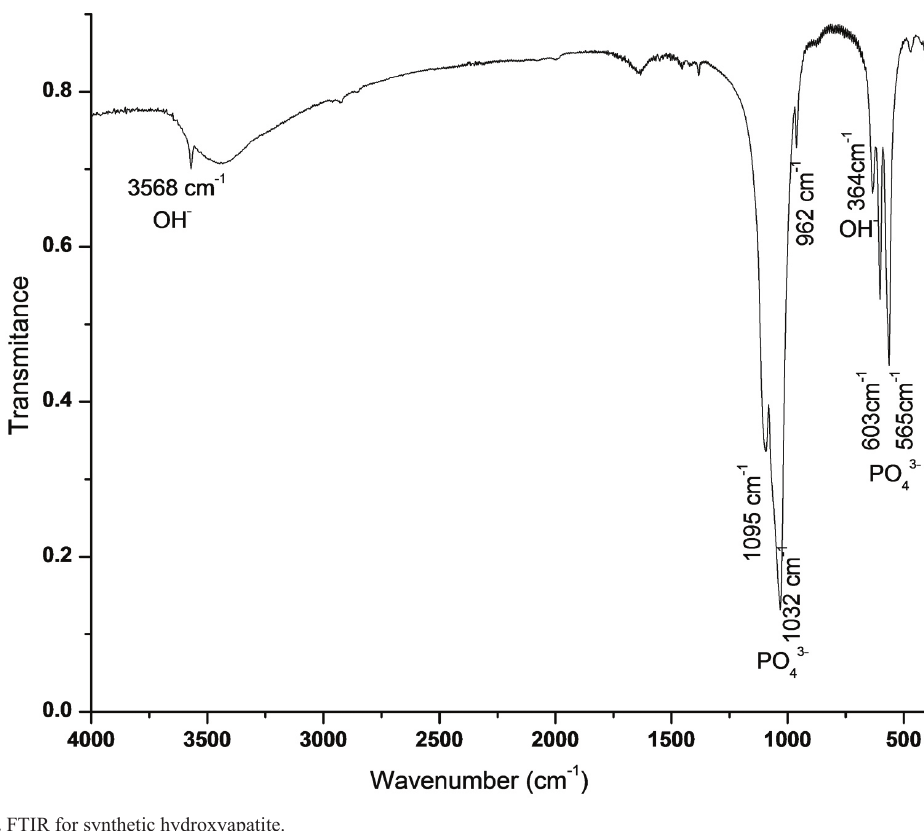
Figure 2. FTIR for synthetic hydroxyapatite.